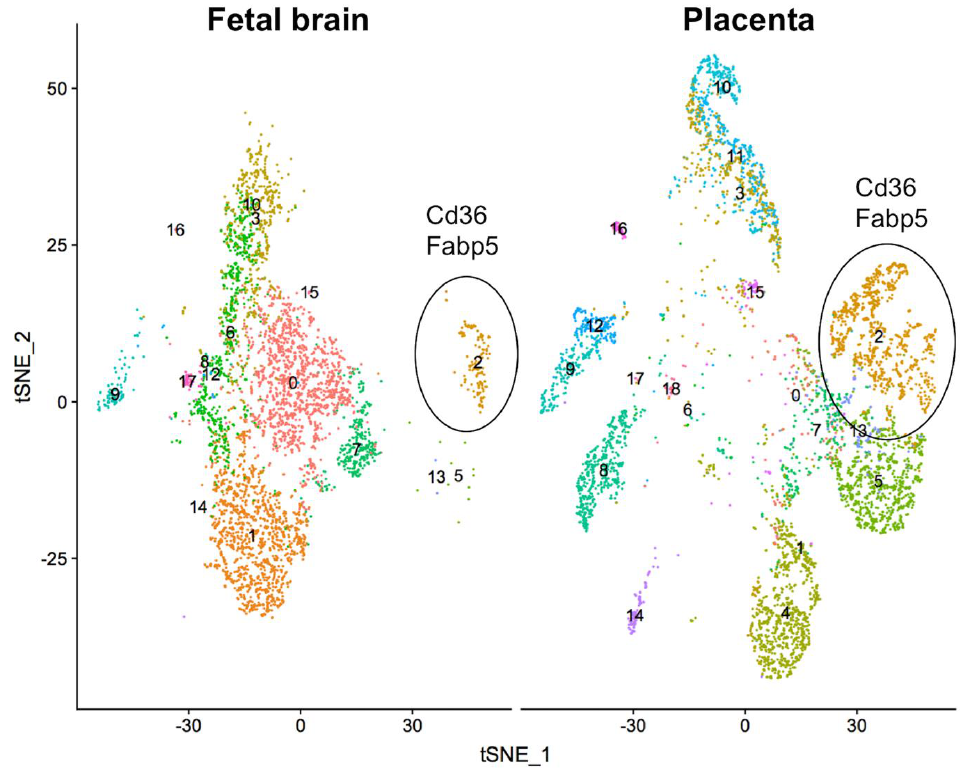
Figure 6. Meta-analysis of DEGs of placenta and fetal brain samples (n = 24) from the current study in comparison with the marker genes from a previously published single-cell expression data of mouse fetal brain and placenta [28]. It showed canonical correlation in gene expression in different clusters of cells (numbered) between fetal brain and placenta. The cluster #2 was identified as endothelial cells based on marker genes CD36 and Fabp5 .